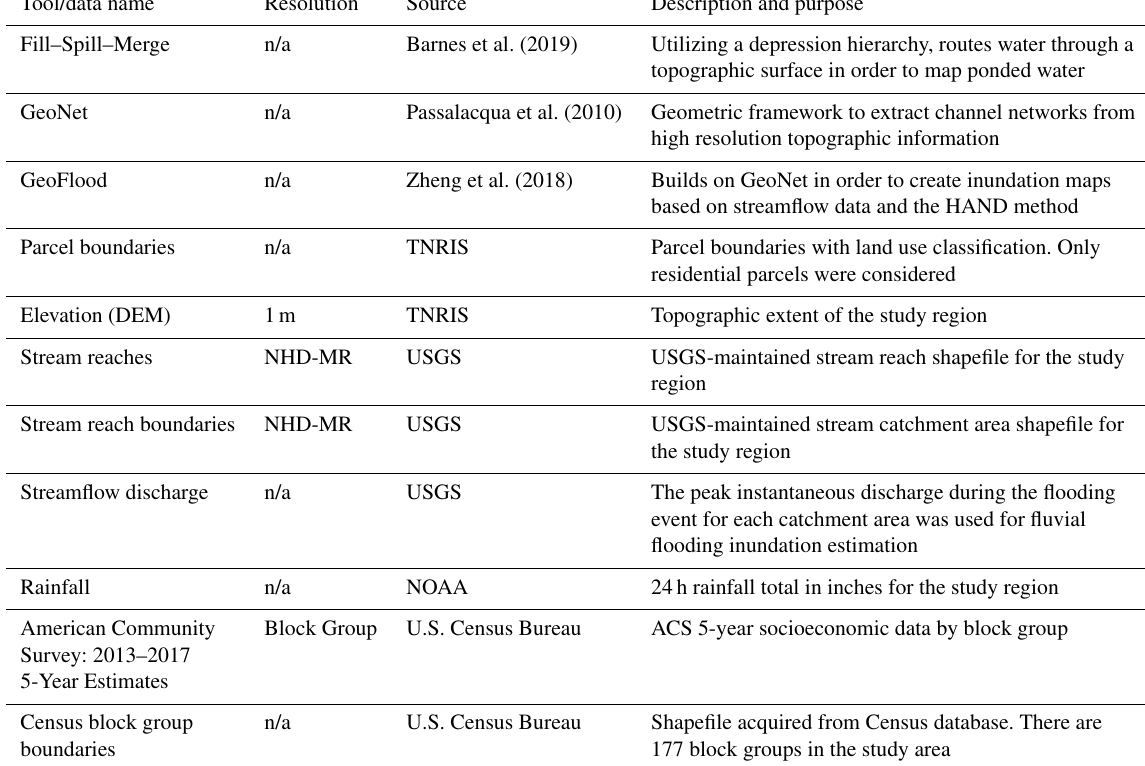
Table 2. Programming tools and data sources utilized in this